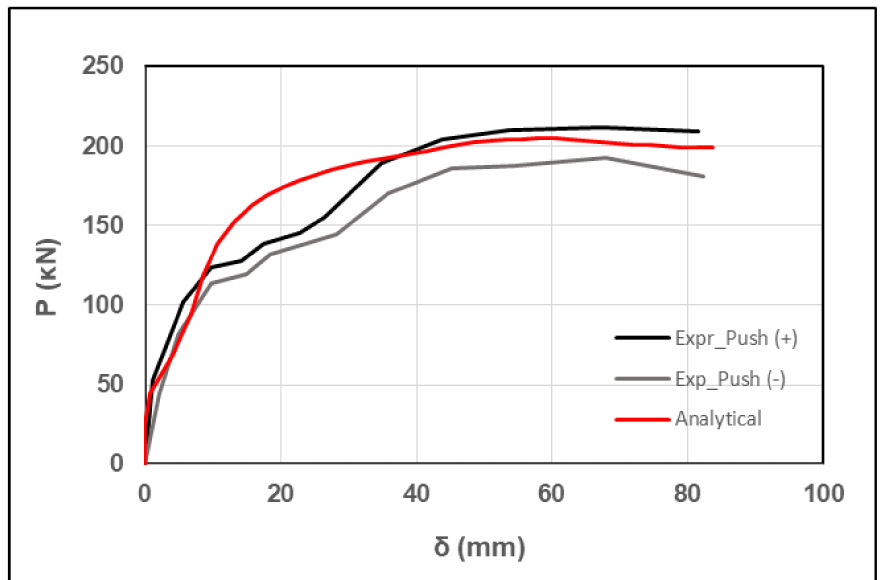
Figure 4. Analytical base shear force–displacement curve for A2R, compared against the experimental